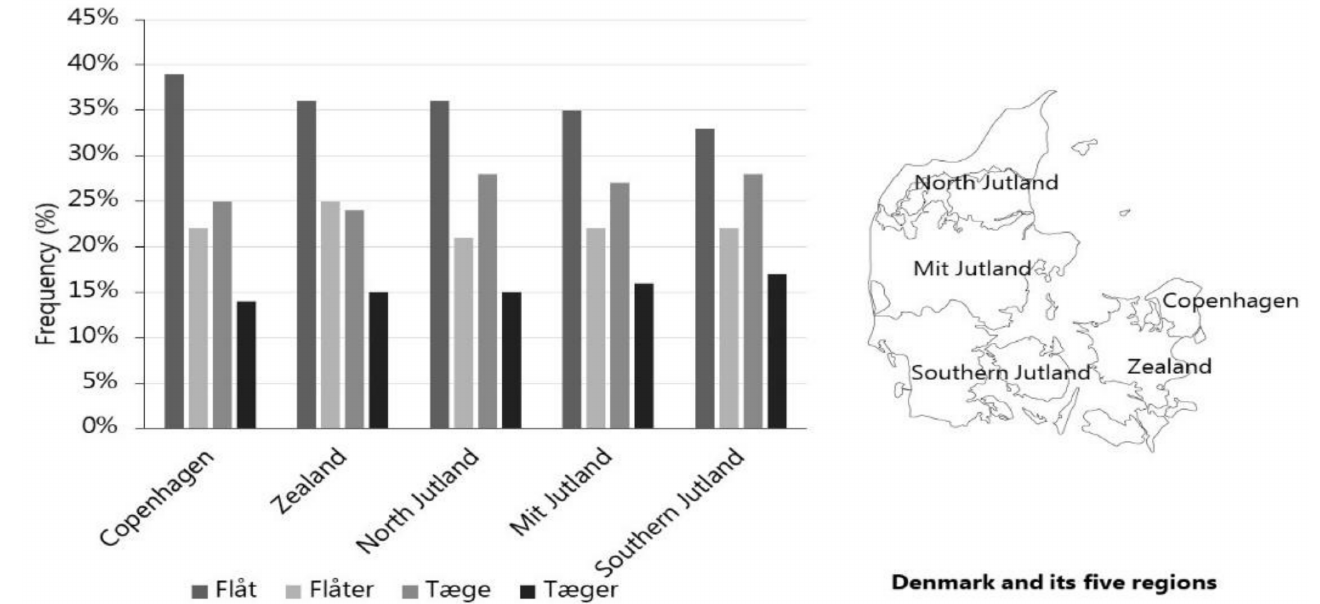
Figure 1. The reported relative search-frequencies for four different Danish tick terms: “flåter”, “flåt”, “tæger”, “tæge” in different regions of Denmark in the period 2007–2019. Thus, the trends over the years were positive for the term “flåter”, while there was no particular trend for “tæger” (Table 1). The search term “flåt” also increased in frequency over the years in Southern Denmark. In contrast, the term “tæger” declined in frequency.